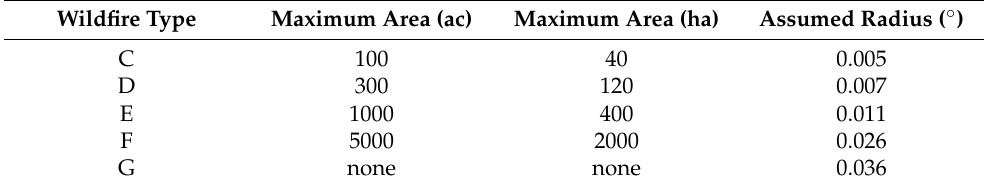
Table 1. Wildfire areas by type with equivalent radii in degrees. Measurements assume the coordinate system is either the North American Datum of 1983 or the World Geodetic System of 1984 [33]. Wildfire